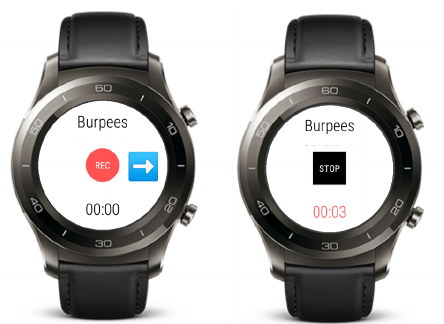
Figure 3. Workout screen. The left image shows the state before starting the recording. The right image shows the state during the